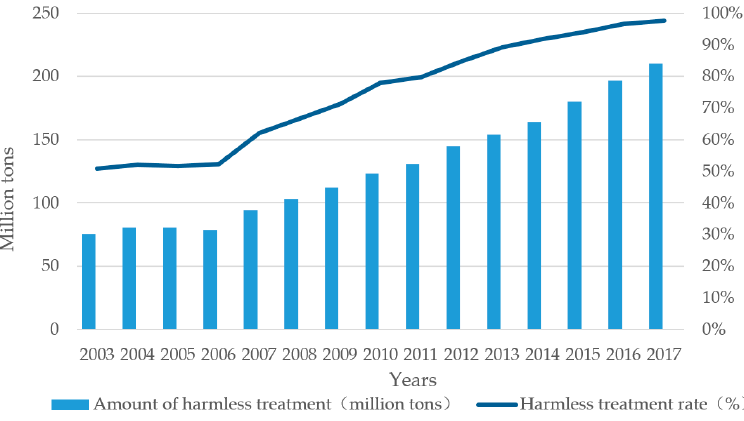
Figure 1. Harmless treatment of municipal solid waste (MSW) in China in the past 15 years.